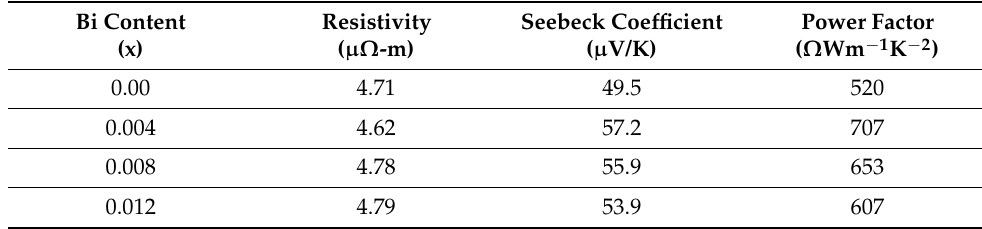
Figure 8. ( a ) Temperature-dependent resistivity plot of Cu 2 − x Bi x Se (x = 0.00, 0.004, 0.008, 0.012) samples, ( b ) comparison of resistivity of the synthesized composition with existing literature on Cu 2 Se with different dopants [2,16–18,27]. Table 5. Value of Resistivity, Seebeck coefficient, Power factor for Cu 2 − x Bi x Se (x = 0.00, 0.004, 0.008, 0.012) samples at 300 K.